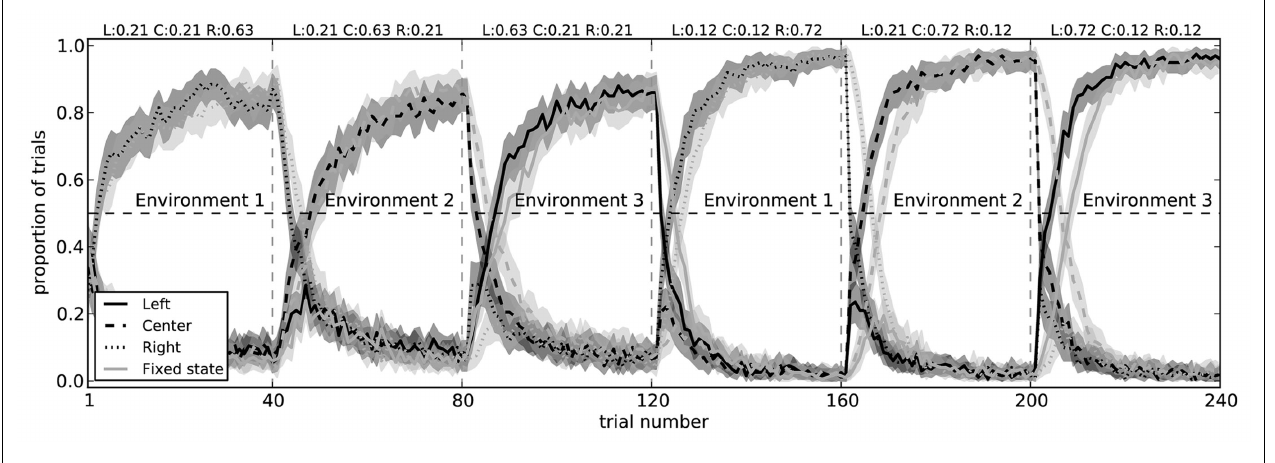
FIGURE 10 | Model performance on a three-arm bandit task with fixed state information (light gray) and with state that changes for each block (dark gray). In both conditions, the model successfully learns to choose the action which most often gives it a reward.When the state